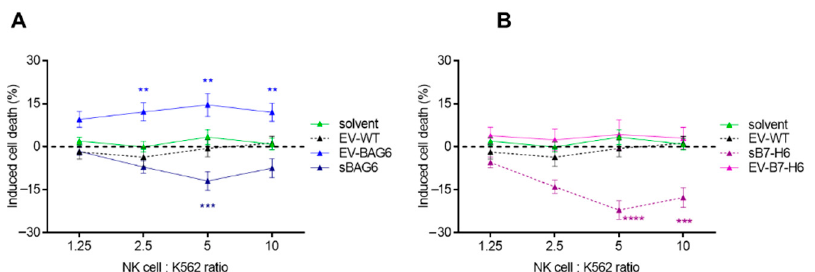
Figure 3. Killing response of natural killer (NK) cells after pretreatment with EVs or soluble proteins. NK cells were either ( A ) pretreated with EV-BAG6 and sBAG6 or ( B ) with EV-B7-H6 and sB7-H6 for 24 h before killing assays using K562 were performed. The killing of untreated NK cells